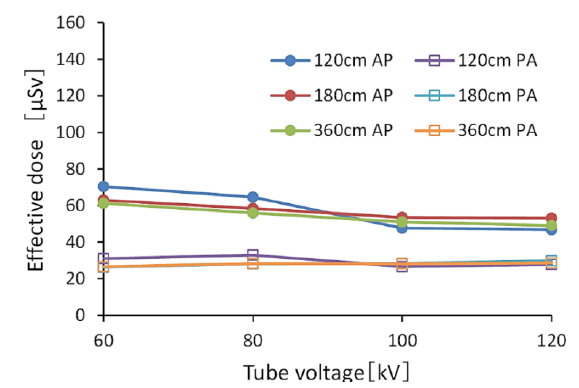
Figure 4. The effective dose calculated by the PC-based Monte Carlo program for calculating patient doses in medical X-ray examinations (without a grid). (AP: anteroposterior, PA: posteroanterior).